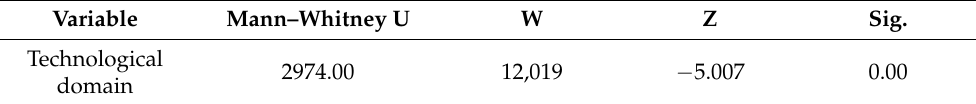
Table 6. Relationship of the technological domain with digital teaching competence